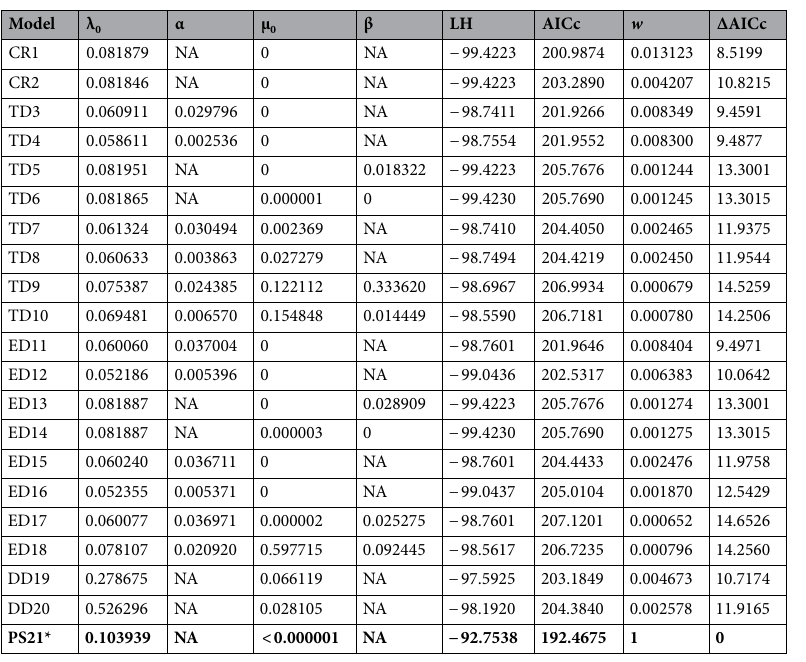
Table 1. Models of diversification for ingroup taxa, with empirical speciation (λ 0 ) and extinction (µ 0 ) rates, sign and rapidity of their variation (α and β, respectively), log-likelihoods and the respective AICc and Akaike weight ( w ) values. The best fitting model with the lowest ΔAICc is highlighted in bold. Models were tested with RPANDA [108] in most cases, except in the case of DD and PS models, which used DDD [111] and ProSSE functions [112], respectively. Models: constant speciation (CR1) and constant extinction (CR2); exponential (TD3) and linear (TD4) time-dependence of speciation and no extinction; exponential (TD5) and linear (TD6) time-dependence of extinction and constant speciation; exponential (TD7) and linear (TD8) time- dependence of speciation and constant extinction; exponential (TD9) and linear (TD10) time-dependence of speciation and extinction; exponential (ED11) and linear (ED12) temperature-dependence of speciation and no extinction; exponential (ED13) and linear (ED14) temperature-dependence of extinction and constant speciation; exponential (ED15) and linear (ED16) temperature-dependence of speciation and constant extinction; exponential (ED17) and linear (ED18) temperature-dependence of speciation and extinction; exponential (DD19) and linear (DD20) diversity-dependence of speciation and constant extinction; and protracted speciation (PS21). *The reported rate for this model is the speciation initiation rate. The protracted speciation model includes an additional parameter, speciation completion rate (λ) = 0.1401414, for our dataset